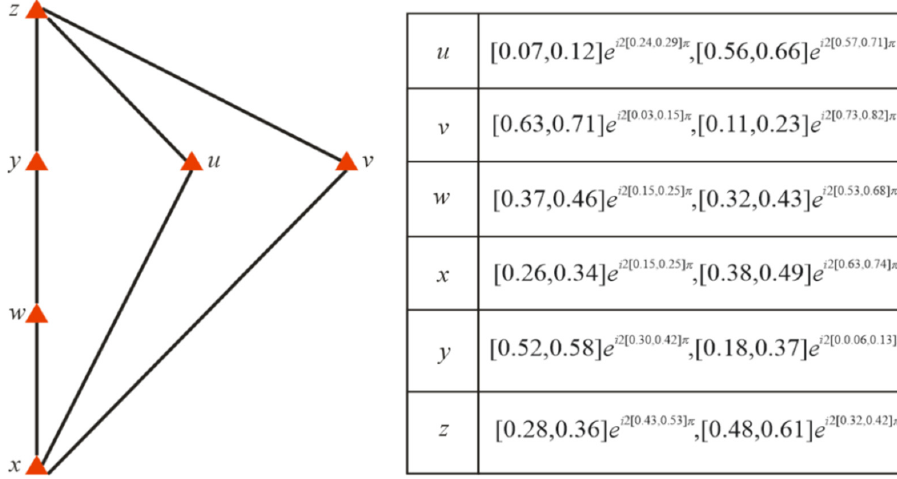
Figure 2. Hasse diagram for an IVCI-partial order-FR Ṝ